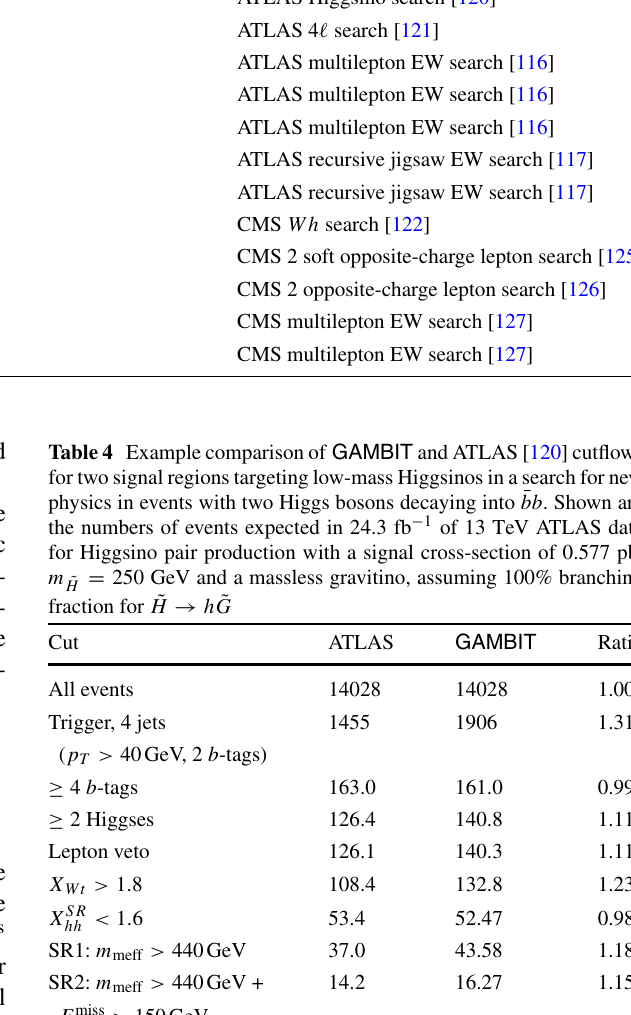
Table 3 Labels for the independent likelihood terms included in our LHC likelihood, along with the analyses from which they are derived